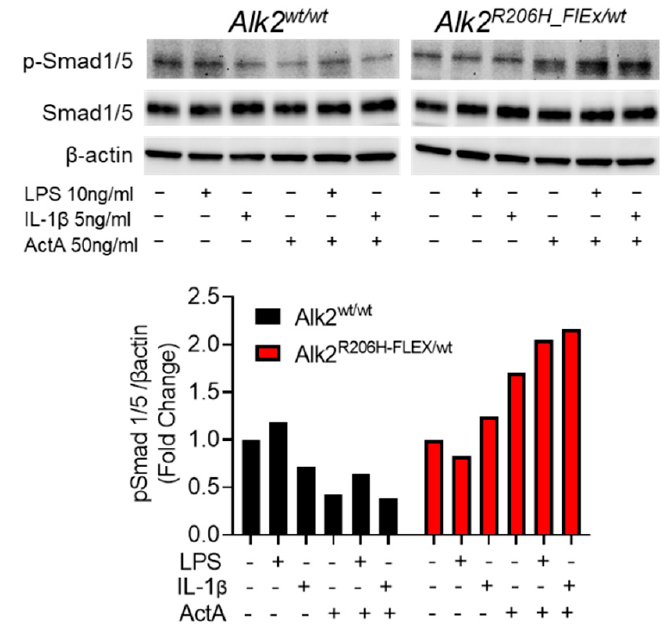
Figure 1. ActA-stimulated canonical BMP signaling in FAPs from FOP mice is enhanced by TLR or IL1R1 ligands. FAPs harvested from the hindlimb muscles of mice with the indicated genotypes were expanded in the presence of 10 ng/mL rhFGF2, serum starved overnight, then stimulated with the indicated ligands for 15 min. In Alk2 wt/wt FAPs, pSmad1/5 was unaffected by LPS or ActA alone but decreased by IL-1 β alone or in combination with ActA. However, in FAPs expressing Alk2 R206H , pSmad1/5 was increased by ActA alone, and this was further increased by addition of LPS or IL-1 β .